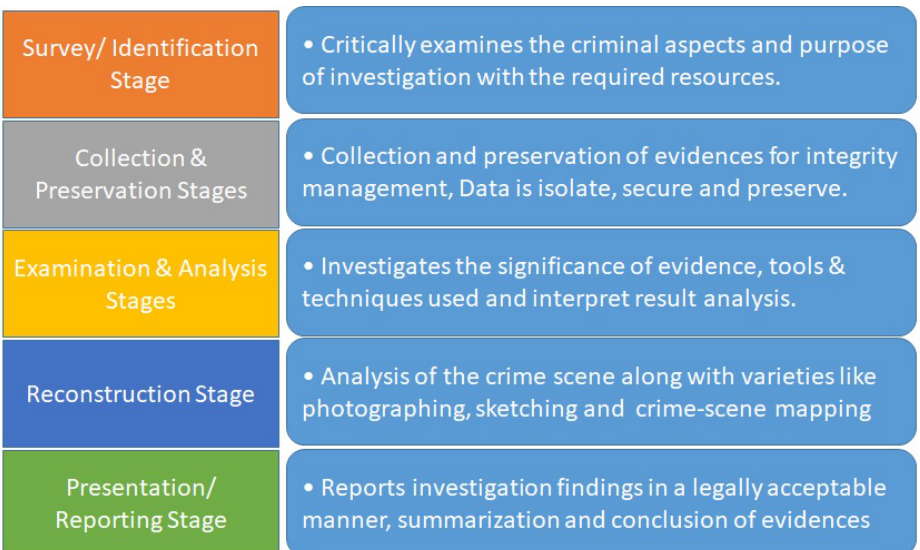
Figure 1. Digital forensic investigation